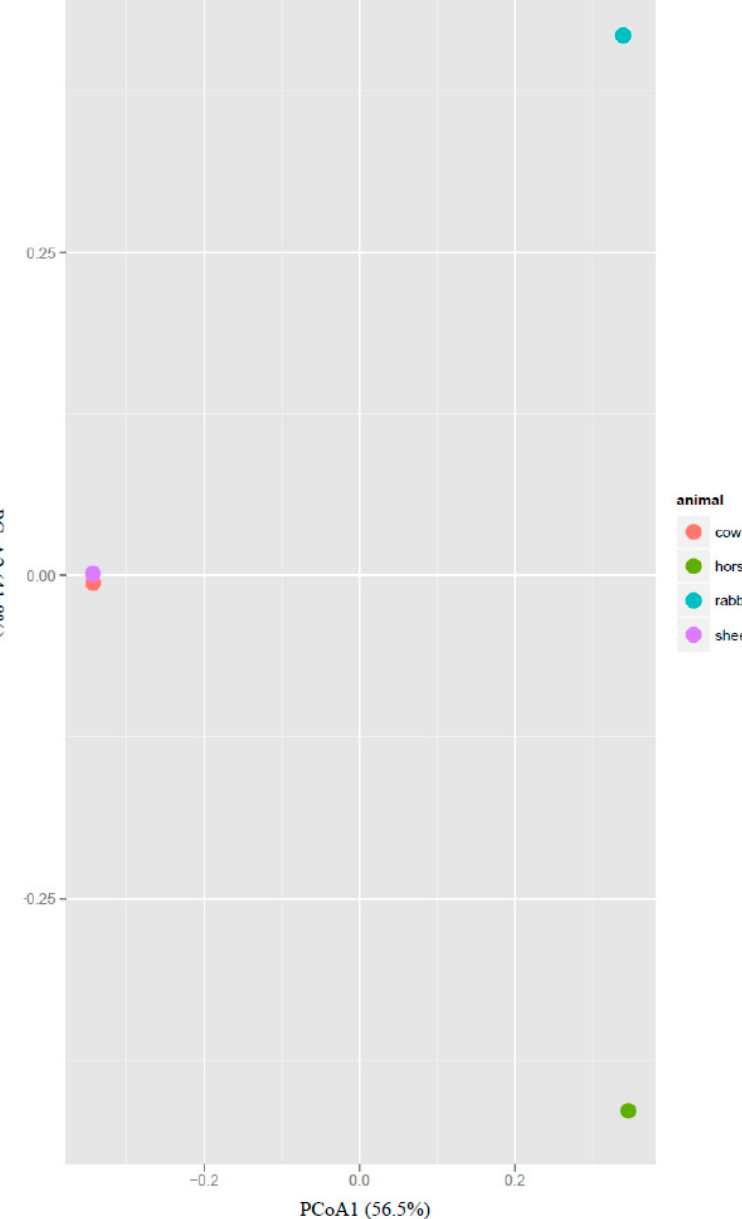
Figure 2. Covariation of the community structure of potential acetogens in the rumens of cows and sheep, the ceca of rabbits and the feces of horses using principal coordinate analysis (PCoA). The PCoA plot shows that the samples from different host species span their first two principal components, principal coordinate 1 (56.5% of variance) and principal coordinate 2 (41.8% of variance).